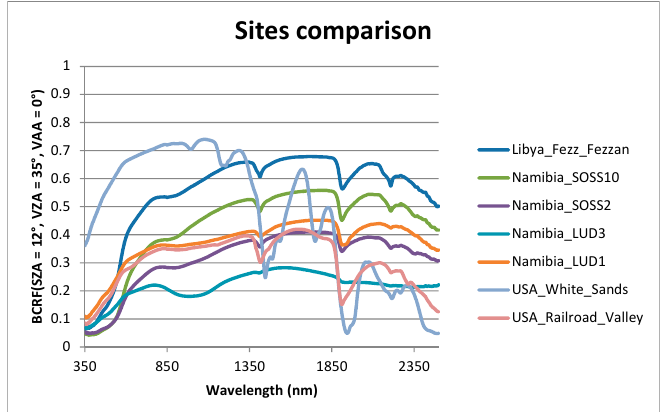
Figure 9. Spectral variation of BCRF for some of the small sand samples .